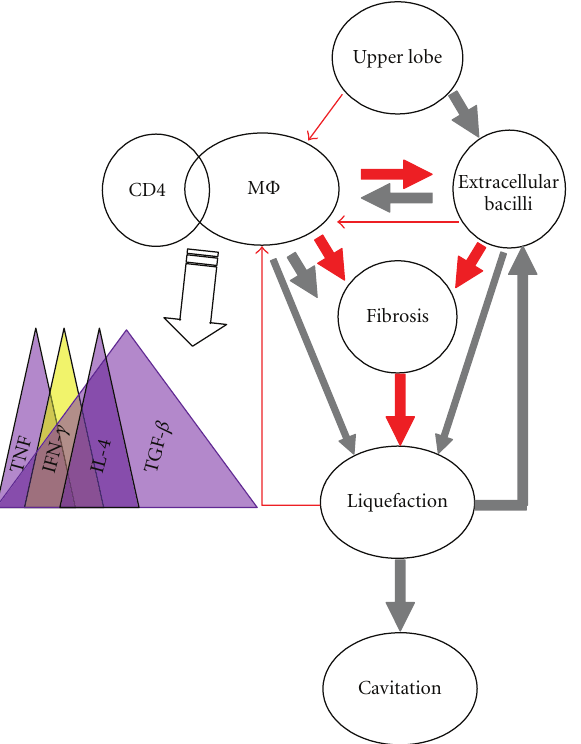
Figure 1: Interactions between the factors involved in the liquefaction process. The colour of the arrows shows the ability to induce a process (in gray) or inhibit it (in red), and the thickness of the arrow is proportional to the intensity of this induction. The upper lobe appears to be the sine qua non condition for the process to take place. Macrophage (M Φ ) activation and the presence of CD4 is linked to the appearance of di ff erent cytokines with time: TNF initially, followed by IFN- γ and IL-4, and TGF- β from the onset and peaking at the chronic phase. All those cytokines are profibrotic (in violet) except for IFN- γ (in yellow). This site mainly undergoes a profibrotic process although there is also a nonspecific antifibrotic e ff ect arising from the macrophages and their enzymatic activity. Extracellular bacilli also have antifibrotic activity and promote macrophage activation although they are also thought to inhibit such activation to some extent. Fibrosis prevents liquefaction whereas liquefaction is promoted by macrophages, the immune response, by promoting the apoptosis of infected macrophages, and extracellular bacilli. Liquefaction induces cavitation, inhibits macrophage activation (indeed, it appears to destroy them), and promotes extracellular bacillary growth. Overall, liquefaction comes first, and then the extracellular multiplication of bacilli occurs. Fibrosis, and thus resume of the liquefaction, would occur only after the number of extracellular bacilli is reduced su ffi ciently to allow attempts at healing to take place. Finally, a large number of extracellular bacilli results in tissue destruction, cavity formation, and the death of the macrophages that attempt to inhibit such bacillary